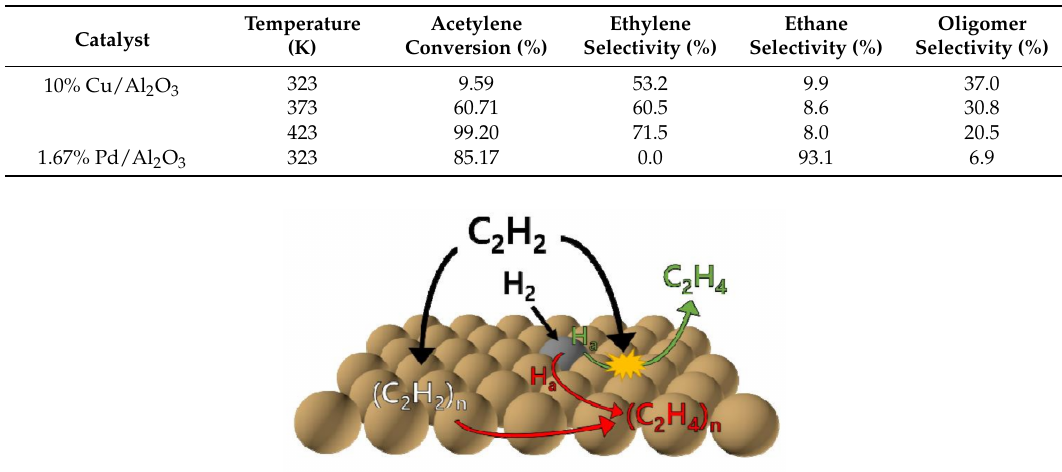
Figure 21. Proposed mechanism of acetylene hydrogenation over a Pd/Cu catalyst with deposited carbonaceous layer (reproduced with permission from r [287].